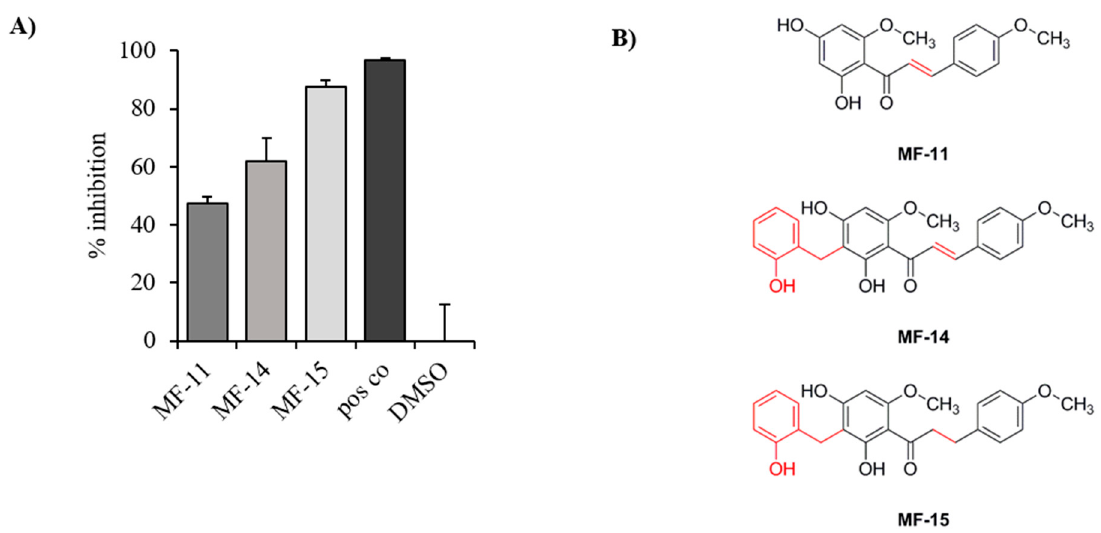
Figure 1 . Inhibitory activities towards AKR1C3 of three compounds designated MF-11, MF-14 and MF-15. ( A ) Three compounds with a chalcone and dihydrochalcone scaffold were tested upon their capacity to inhibit AKR1C3 at a concentration of 10 µM using an enzyme inhibition assay as described under material and methods. Data are represented as mean percentage inhibition plus SEM of three independent experiments compared to the mock control (DMSO). A positive control (CAS 745028-76-6) was used at a concentration of 1 µM. ( B ) Chemical structures of MF-11, MF-14, and MF-15 with 2 ′ -(2-hydroxy)-benzyl moiety are marked in red.